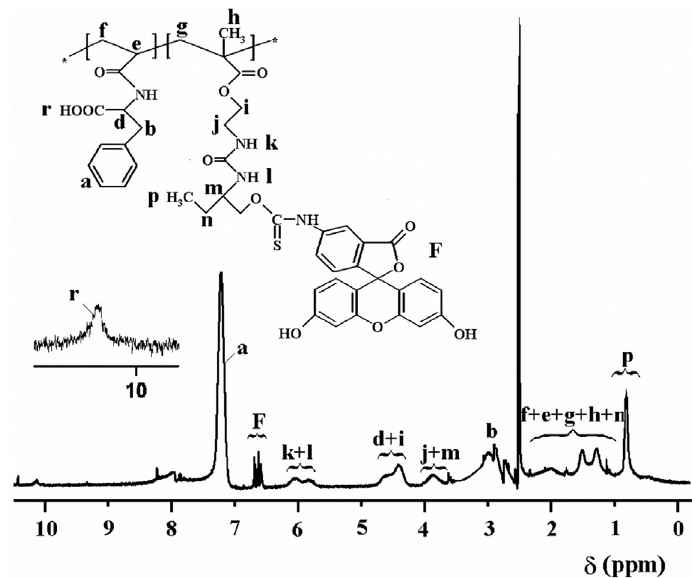
Figure 3. 1 H-NMR spectrum of the A-L-Phe- co -L-MABU-F copolymer functionalized with fluorescein units, in DMSO- d